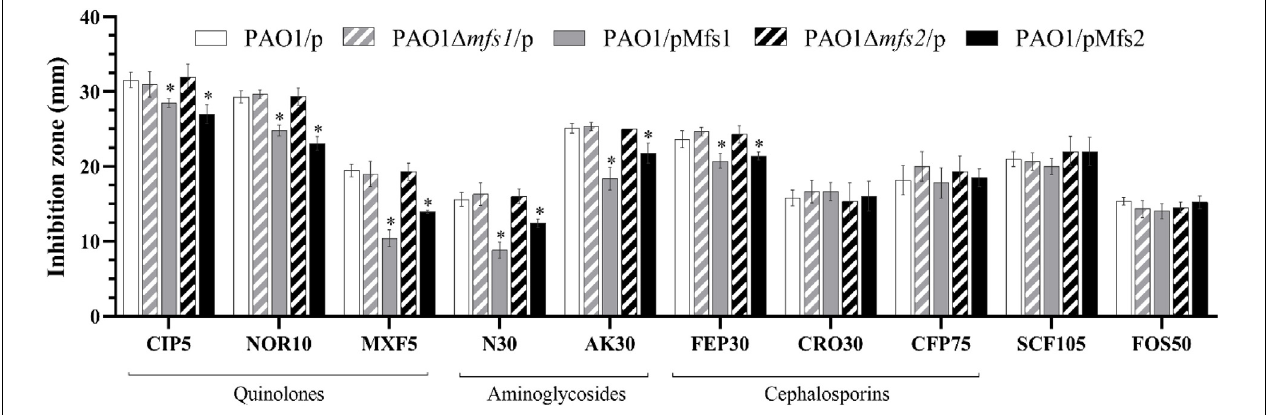
FIGURE 2 | Antibiotic susceptibility against the fluoroquinolones, ciprofloxacin (CIP, 5 µ g in disk), norfloxacin (NOR 10 µ g), moxifloxacin (MXF 5 µ g); aminoglycosides, neomycin (N 30 µ g), amikacin (AK 30 µ g); cephalosporins, cefepime (FEP 30 µ g), ceftriaxone (CRO 30 µ g), cefoperazone (CFP 75 µ g); and cefoperazone/sulbactam 2:1 (SCF 105 µ g), and fosfomycin (FOS 30 µ g) for PAO1/p, PAO1 (cid:49) mfs1 /p, PAO1/pMfs1, PAO1 (cid:49) mfs2 /p, and PAO1/pMfs2. Data presented are means ± standard deviations of three biological replicates. Asterisk ( ∗ ) indicates significant difference relative to PAO1/p ( p- value < 0.05).